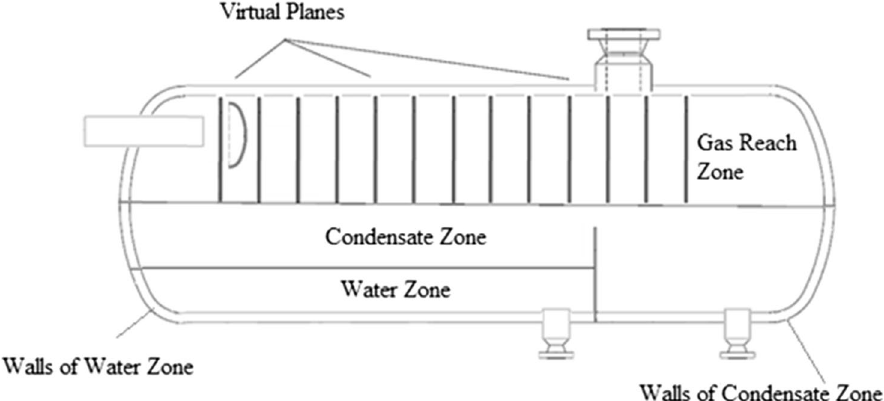
Fig. 13 Location of the virtual planes inside the vessels to calculate the secondary-phase mass